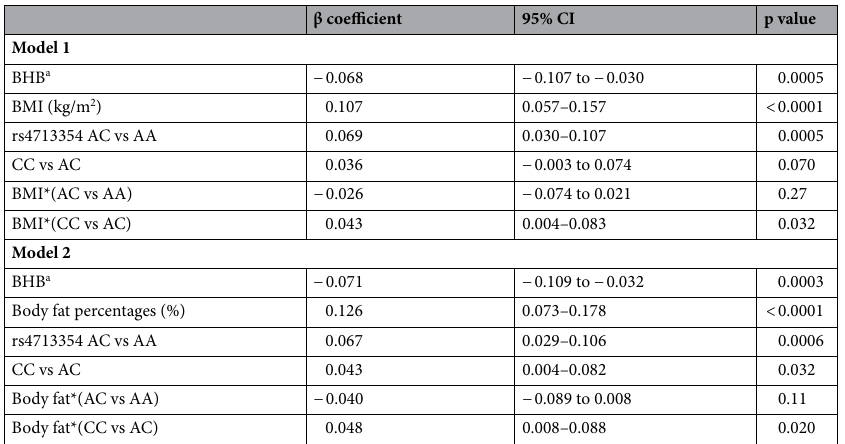
Table 3. Multivariate analysis in never-smokers for elevated blood eosinophil counts including BHB, BMI or body fat, rs4713354, and its interactions as variables. BHB β-hydroxybutyric acid, BMI body mass index, β coefficient standardized partial regression coefficient, CI confidence interval. a Log-transformed. Adjusted by age, sex, elapsed time after a meal, medication for dyslipidemia, serum HDL cholesterol, serum triglycerides, serum total IgE and high-sensitivity CRP.